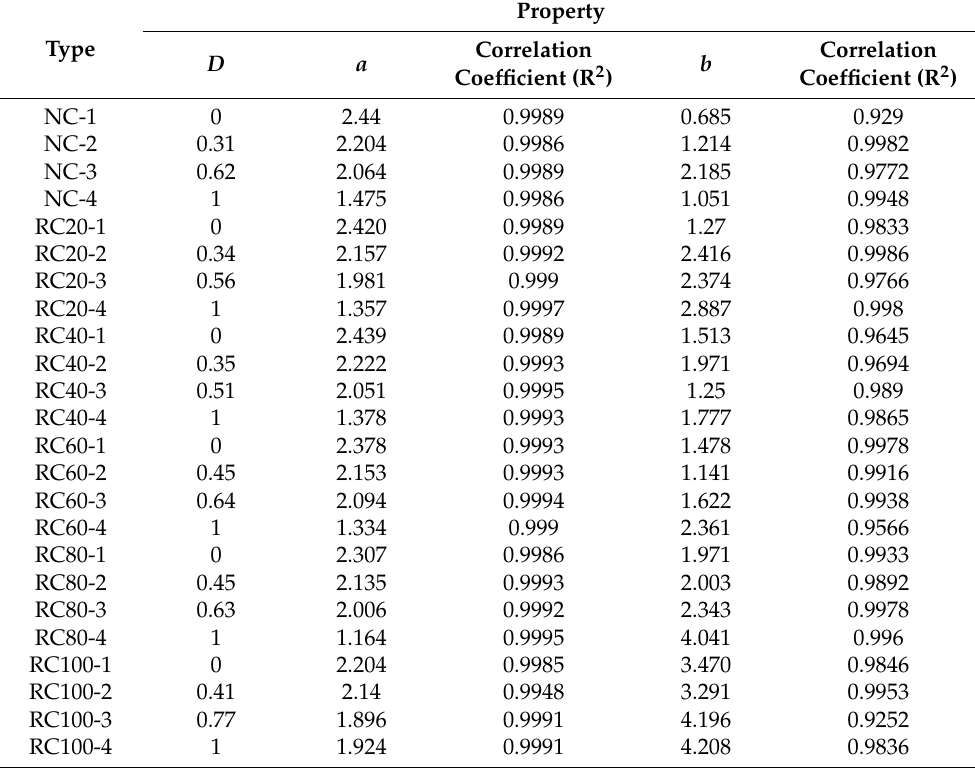
Table 7. The shape parameters a , b and corresponding correlation